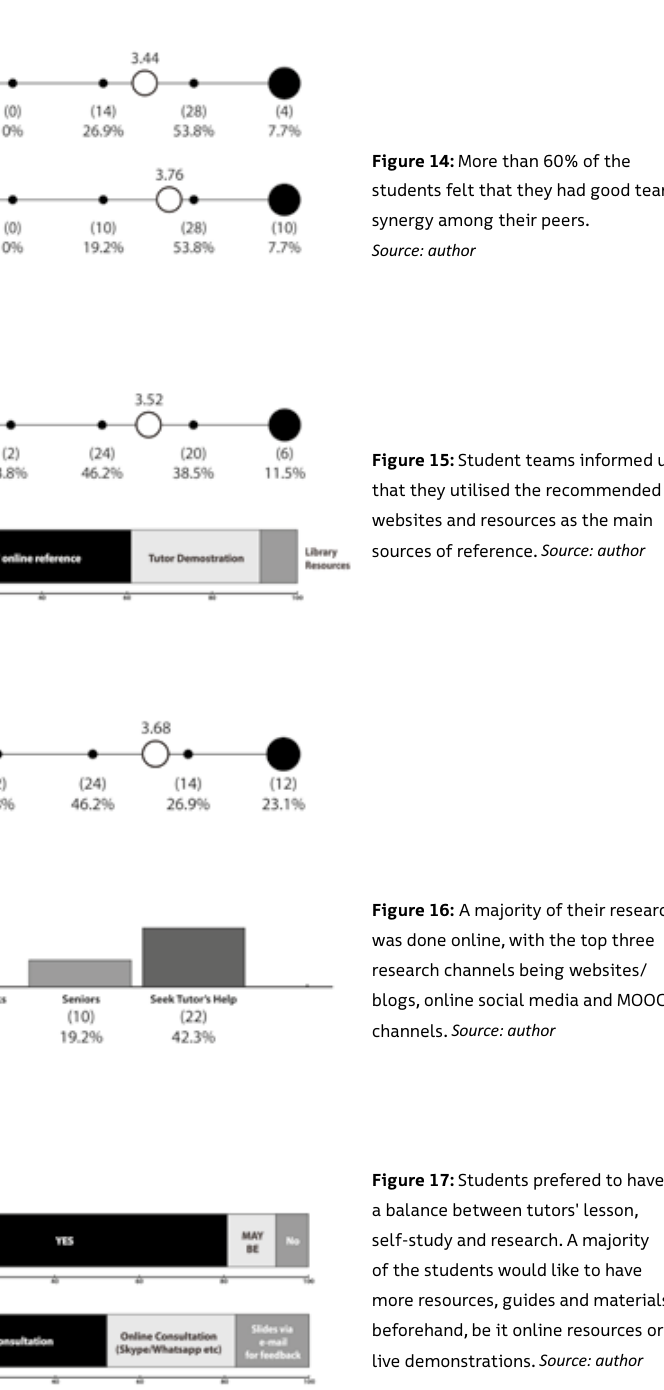
Figure 17: Students prefered to